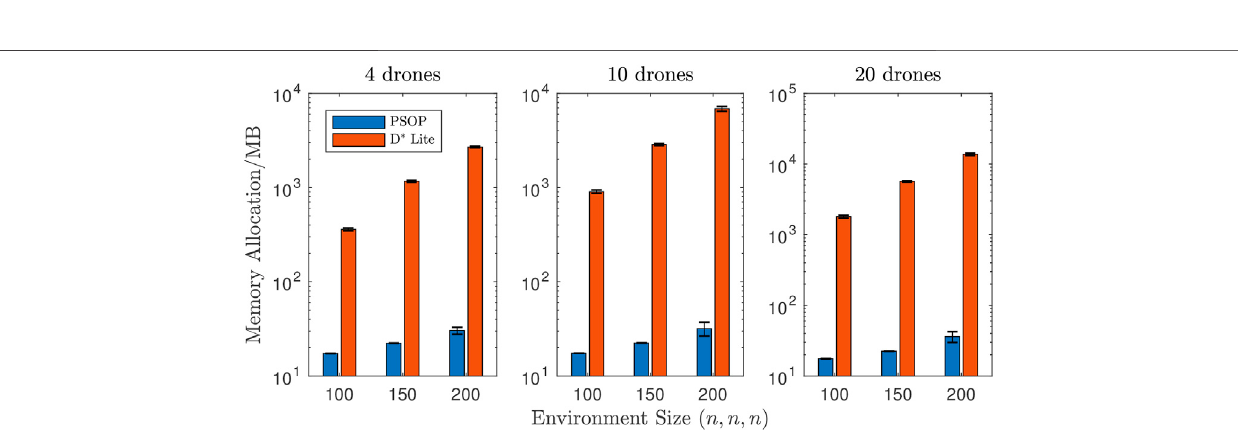
FIGURE 4 | Weighted median frametime by environment size. Across all nine scenarios the weighted-median required frametimes were shown to be extremely similar with only a 0.027% variation between the highest and lowest weighted-median frametime.